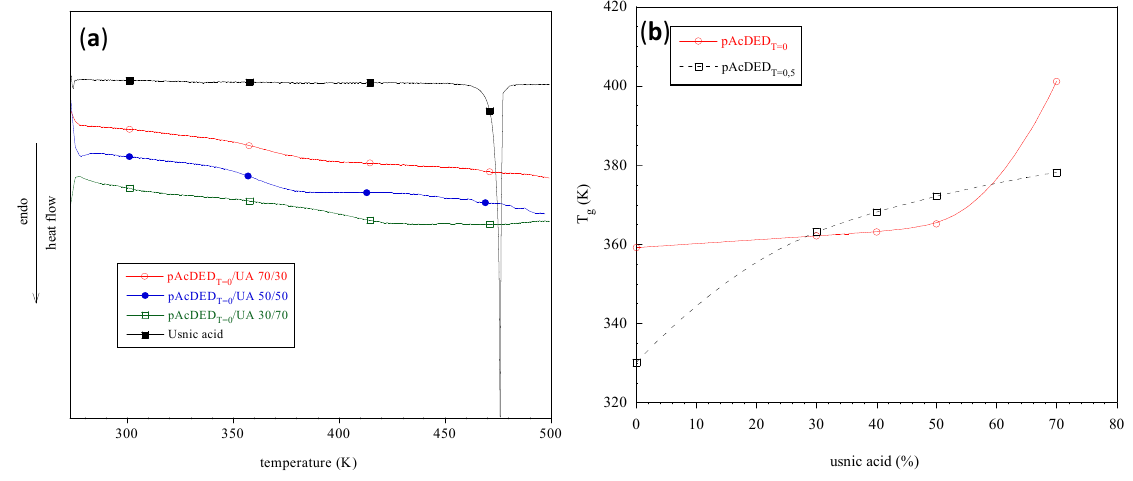
Figure 3. Differential scanning calorimetry (DSC) curves of usnic acid and /usnic acid (UA) complexes ( a ); dependence of polymer glass transition pAcDED T=0 temperature on usnic acid content for pAcDED were determined by the first derivative of the curve obtained in the first heating